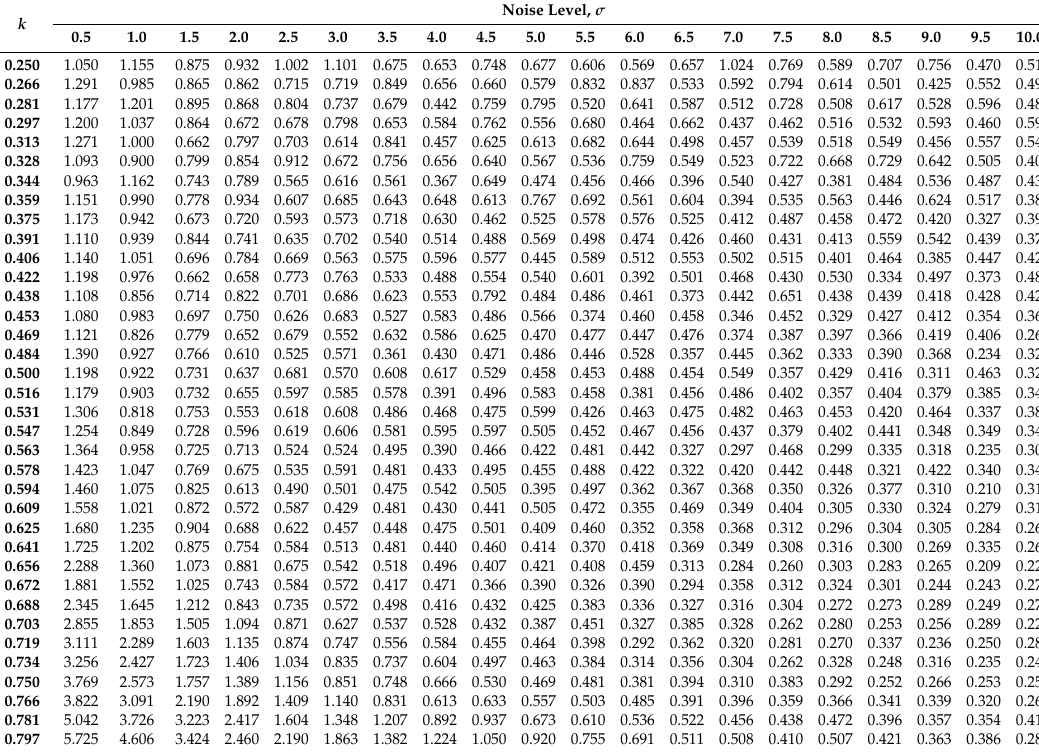
Table A1. For the block size of 128 × 128, MSE levels across a range of noise levels and normalized singular value tail length k values.